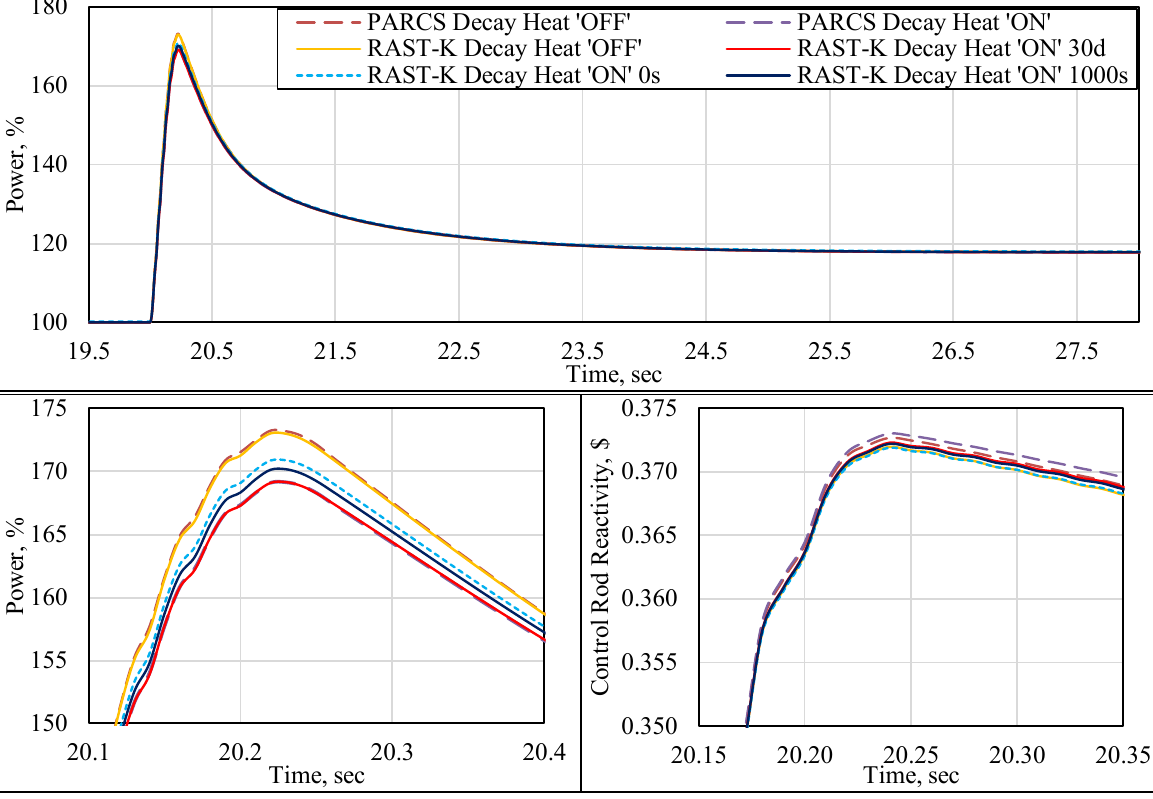
Figure 3. Power change for the NEACRP HFP REA scenario (bottom left - hand side – impact of DH on the value of power, bottom right - hand side - impact of DH on the CR